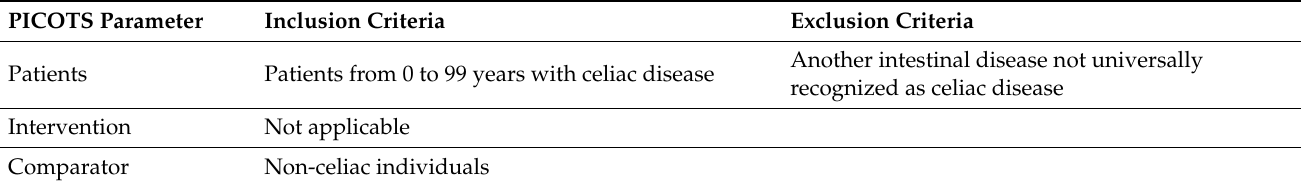
Table 1. PICOTS methodology used in the systematic search about oral and dental manifestations in celiac